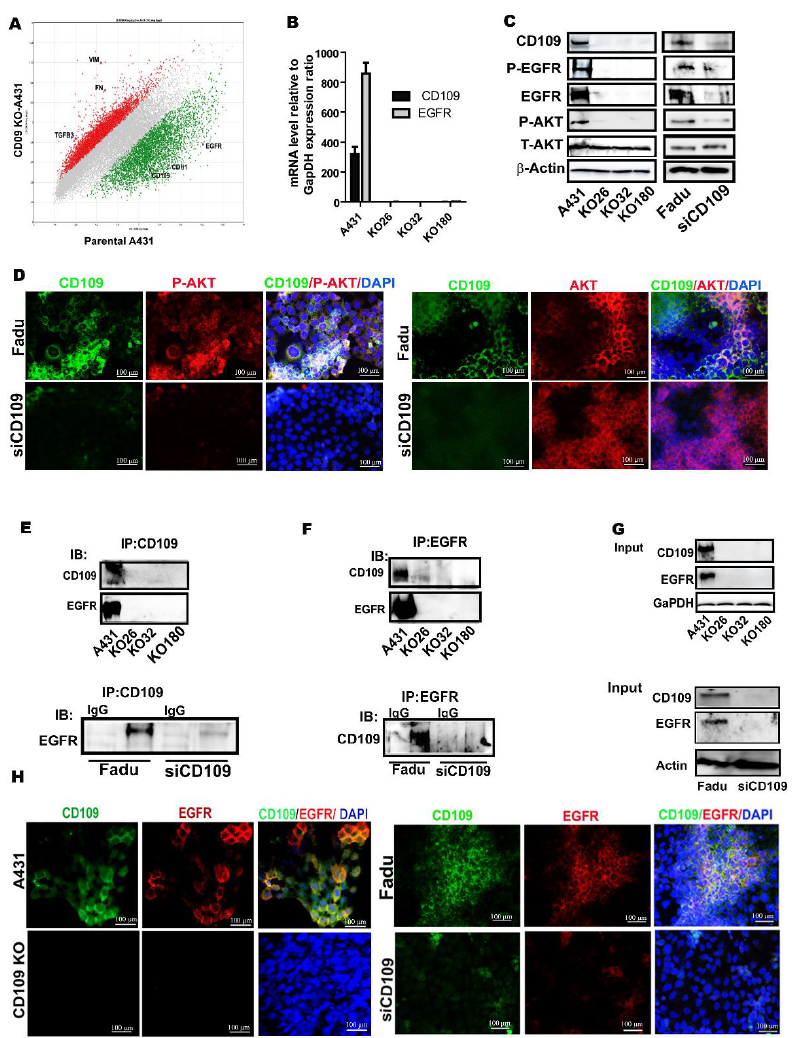
Figure 4. CD109 associates and co-localizes with EGFR, and loss of CD109 diminishes EGFR expression in SCC cells. ( A ): Scatter plot of microarray data from control A431 versus CD109KO A431 cells analysis indicates that EGFR is markedly downregulated in CD109 KO cells. ( B ): Quantitative PCR analysis of CD109 and EGFR gene expression in A431 control cells and three CD109 KO A431 clones. ( C ): Western blot analysis of indicated proteins in control A431 versus CD109KO A431 clones, and FaDu versus CD109-KD FaDu cells. ( D ): Representative images of immunofluorescence microscopy for FaDu and CD109-KD FaDu cells stained for CD109 (green), pAKT (red), and DAPI (blue). All the images are representative of three independent experiments. Scale bars: 100 µ m. ( E ): Co-immunoprecipitation experiment where immunoprecipitation was conducted with an anti-CD109 antibody followed by western blot using anti-EGFR antibody, with control A431 versus CD109KO A431 clones, and FaDu versus CD109-KD FaDu cells. ( F ): Reverse co-IP where immuno- precipitation was conducted with an anti-EGFR antibody followed by western blot using anti-CD109 antibody, showing EGFR interacts with CD109. ( G ): Input control for the co-IP experiments. All the results were repeated in three independent experiments. ( H ): Immunofluorescence microscopy for control A431 versus CD109KO 32 A431 cells, and control FaDu versus CD109-KD FaDu cells stained for CD109 (green) and EGFR (red) and DAPI (blue). All the images are representative of three independent experiments. Scale bars: 100 µ m. Uncropped WB images were shown in Figure